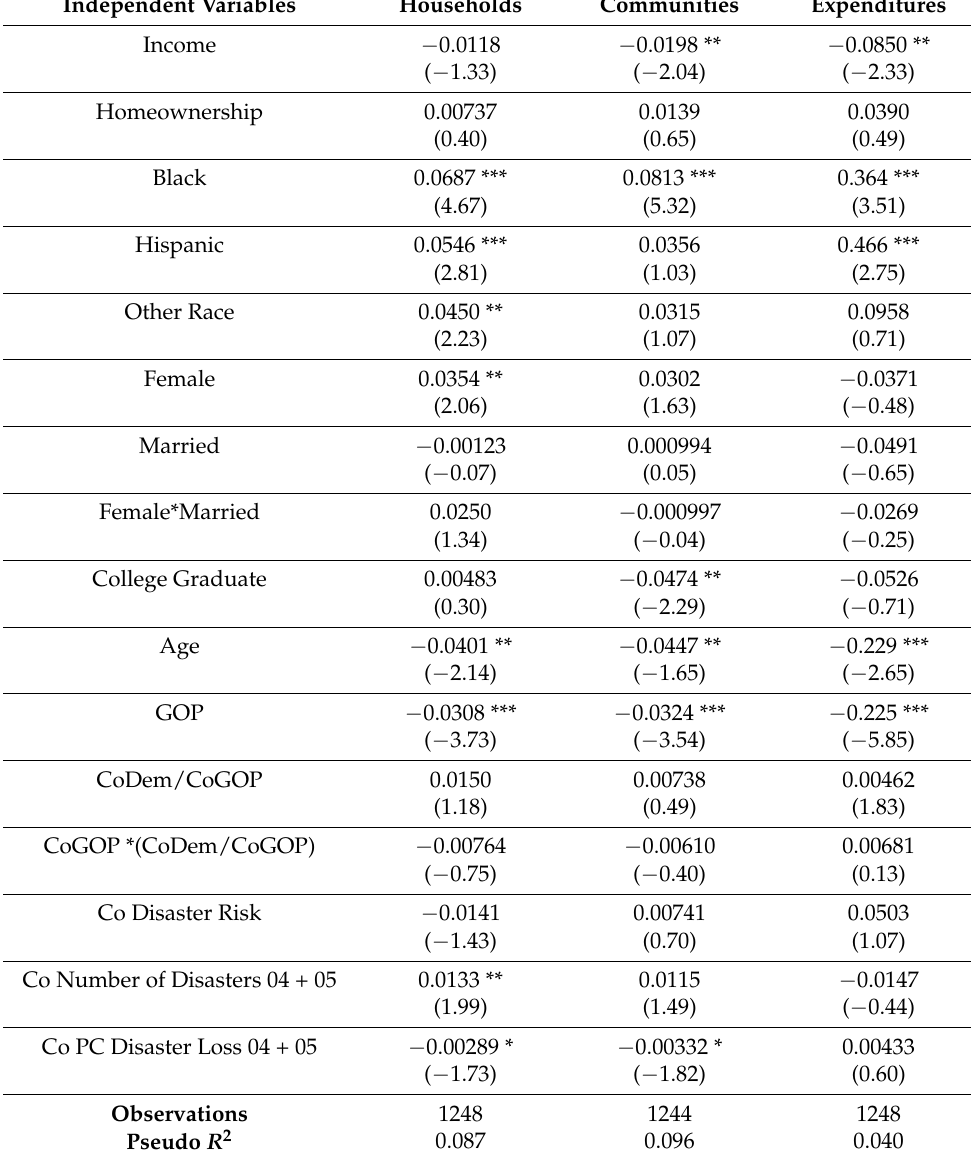
Table 2. Support for Government Disaster Aid (Disaster Loss